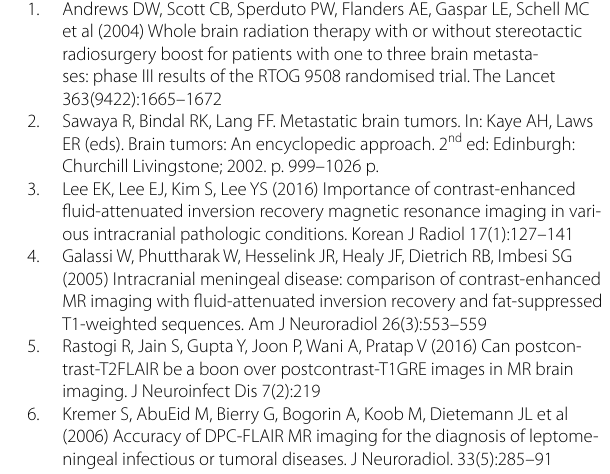
AUC: area under the curve, CI: confidence interval, LL: lower limit, UL: upper limit, PPV: positive predictive value, NPV: negative predictive